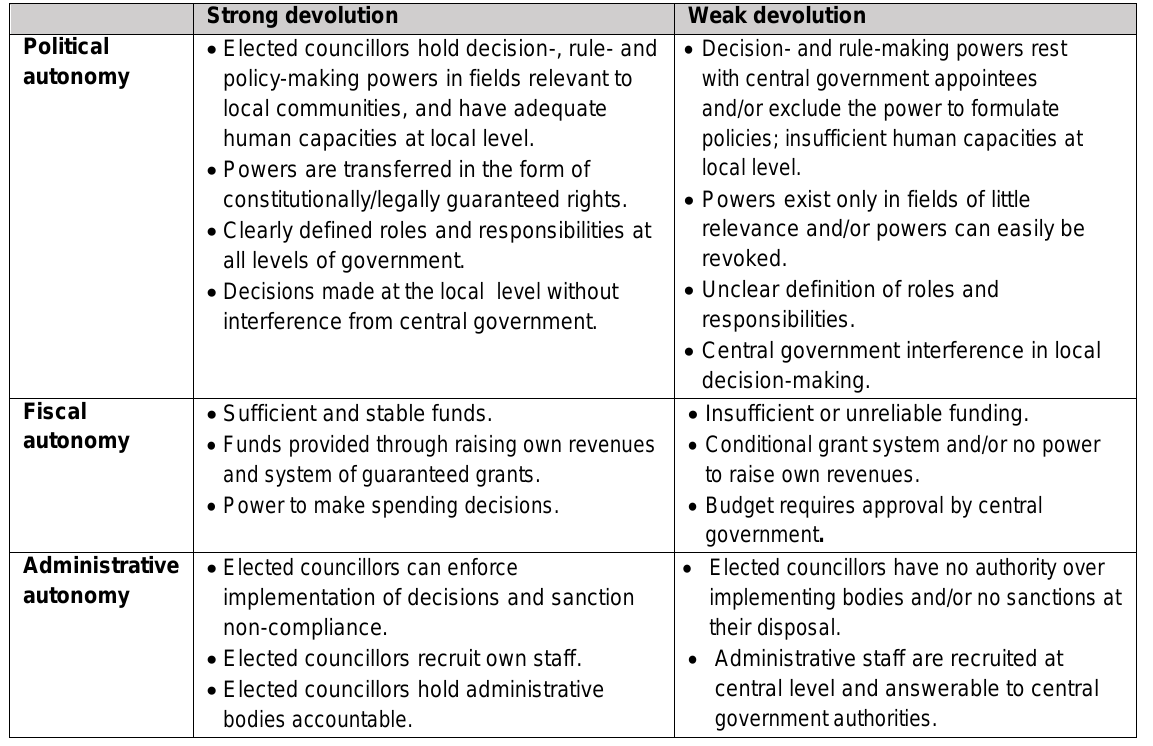
Table 3: Characteristics of strong and weak devolution